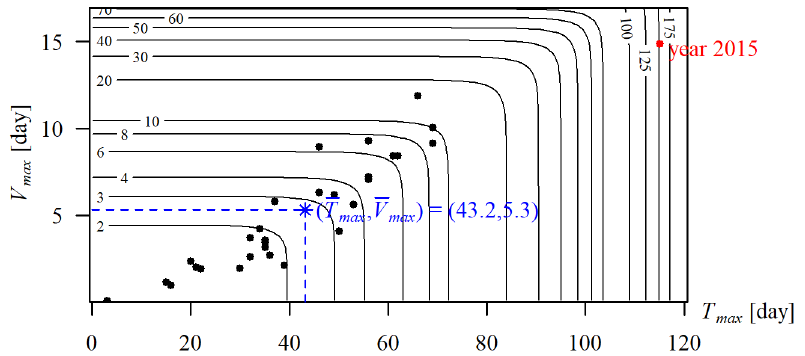
Figure 14. Contour plot for the joint return period T P ( T max , V max ) [in years] at the Żywiec cross -section of the Soła river. The black points indicate a random sample ( T max , V max ). * indicates T p for average values (T max , V max ).